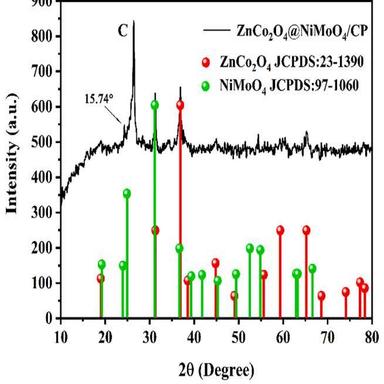
The XRD spectrum of ZnCo2O4@NiMoO4/CP.